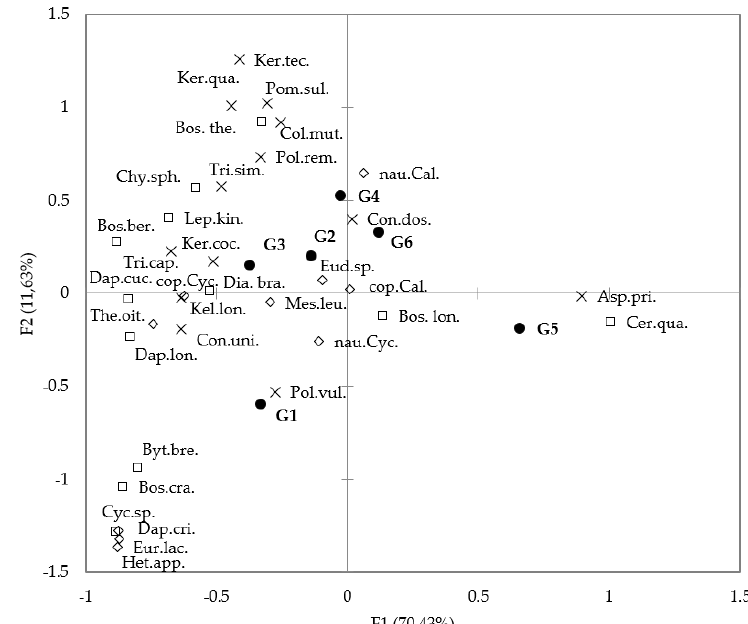
Figure 5. The canonical correspondence analysis ordination of dominant zooplankton taxa in lakes with different oxygen conditions (black dots). Abbreviations Cladocera (white squares): Dap.cuc.— Daphnia cucullata ; Dap.cri.— Daphnia cristata ; Dap.lon.— Daphnia longispina ; Bos.cra.— Bosmina crassicornis ; Bos.ber.— Bosmina berolinensis ; Bos.lon.— Bosmina longispina ; Bos.the.— Bosmina thersites ; Dia.bra.— Diaphanosoma brachyurum ; Cer.qua.— Ceriodaphnia quadrangula ; Lep.kin.— Leptodora kindtii ; Byt.bre.— Bythotrephes brevimanus . Abbreviations Copepoda (rhombs): Eud.sp.— Eudiaptomus species; Eur.lac.— Eurytemora lacustris ; Het.app.— Heterocope appendiculata ; The.oit.— Thermocyclops oithonoides ; Mes.leu.— Mesocyclops leuckarti ; Cyc.sp.— Cyclops species; cop.Cyc.—copepodites Cyclopoida; cop.Cal.—copepodites Calanoida; nau.Cyc.—nauplii Cyclopoida; nau.Cal.—nauplii Calanoida. Abbreviations Rotifera (cross): Pol.vul.— Polyarthra vulgaris ; Pol.rem.— Polyarthra remata ; Con.uni.—